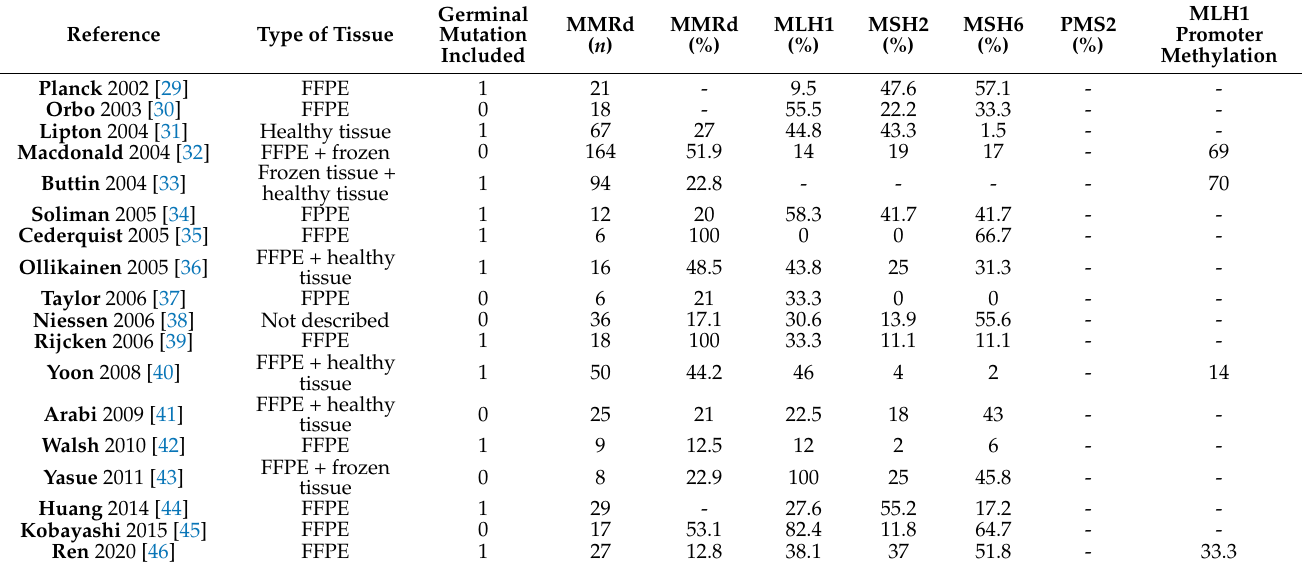
Table 2. Differences in immunohistochemistry protein losses in tumors with microinstability in endometrial cancer using the expression of three proteins.